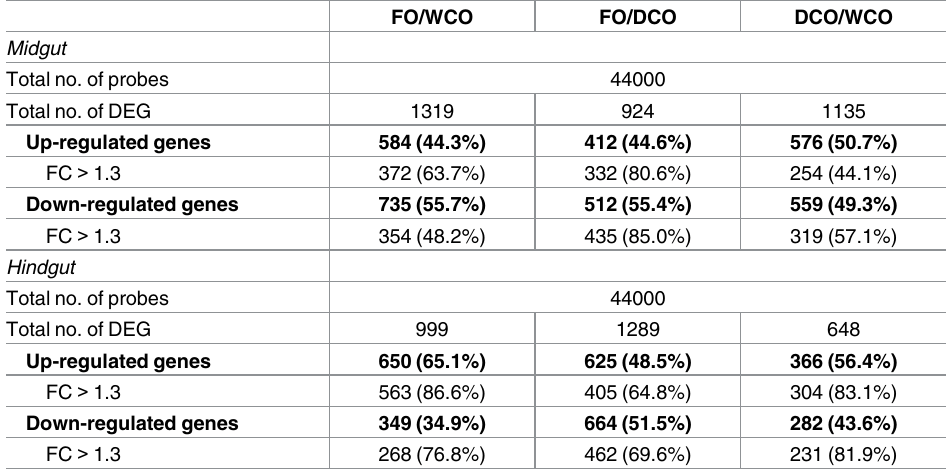
FC > 1.3 231 (81.9%) DCO, feed containing oil from transgenic camelina; DEG, differentially expressed genes; FC, fold change; FO, control (fish oil) feed; WCO, feed containing oil from wild-type